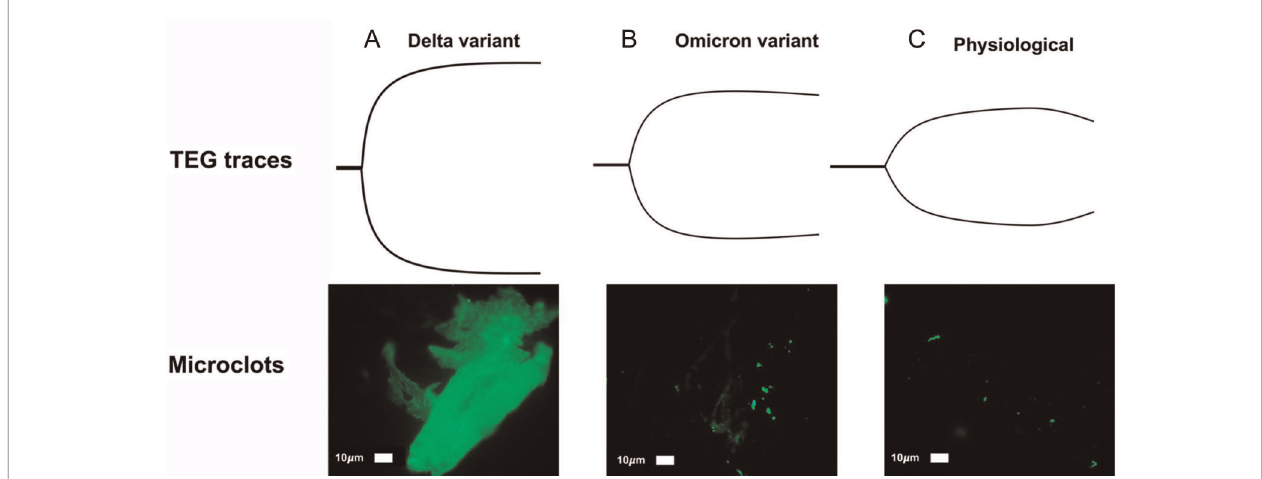
FIGURE 4 | Prototype spectrum of COVID-19-associated coagulopathy used to assess the patient ’ s coagulopathy with thromboelastography (TEG) and plasma microclot analysis. Shown above is an example of correlation between the most hypercoagulable delta (B.1.617.1) variant, intermediate hypercoagulable omicron (B.1.1.529) variant, and physiologic TEGs with corresponding plasma microclot analyses. Using Thio fl avin-T as a fl uorescent marker speci fi cally for microclot staining, fl uorescence microscopy demonstrates microclots in plasma with representative examples of different degrees of microclot formation as related to delta ( A ), omicron ( B ), and physiologic ( C ) TEGs. Previously described, Stage 1 to 4 is a qualitative numerical scoring system where a score of 4 is given for signi fi cant and widespread microclot formation and a score of 1 is given for minimal microclot formation (78, 119). In this fi gure, delta variant ( A ) equals stage 4, omicron (non- hospitalized patient) ( B ) is stage 3, normal physiologic non-infected individual ( C ) is stage 2. A hypocoagulable state either from anticoagulation of the COVID-19 patient or due to naturally acquired disease from COVID-19-associated coagulopathy is stage 1 (not pictured). Patients with Long COVID also